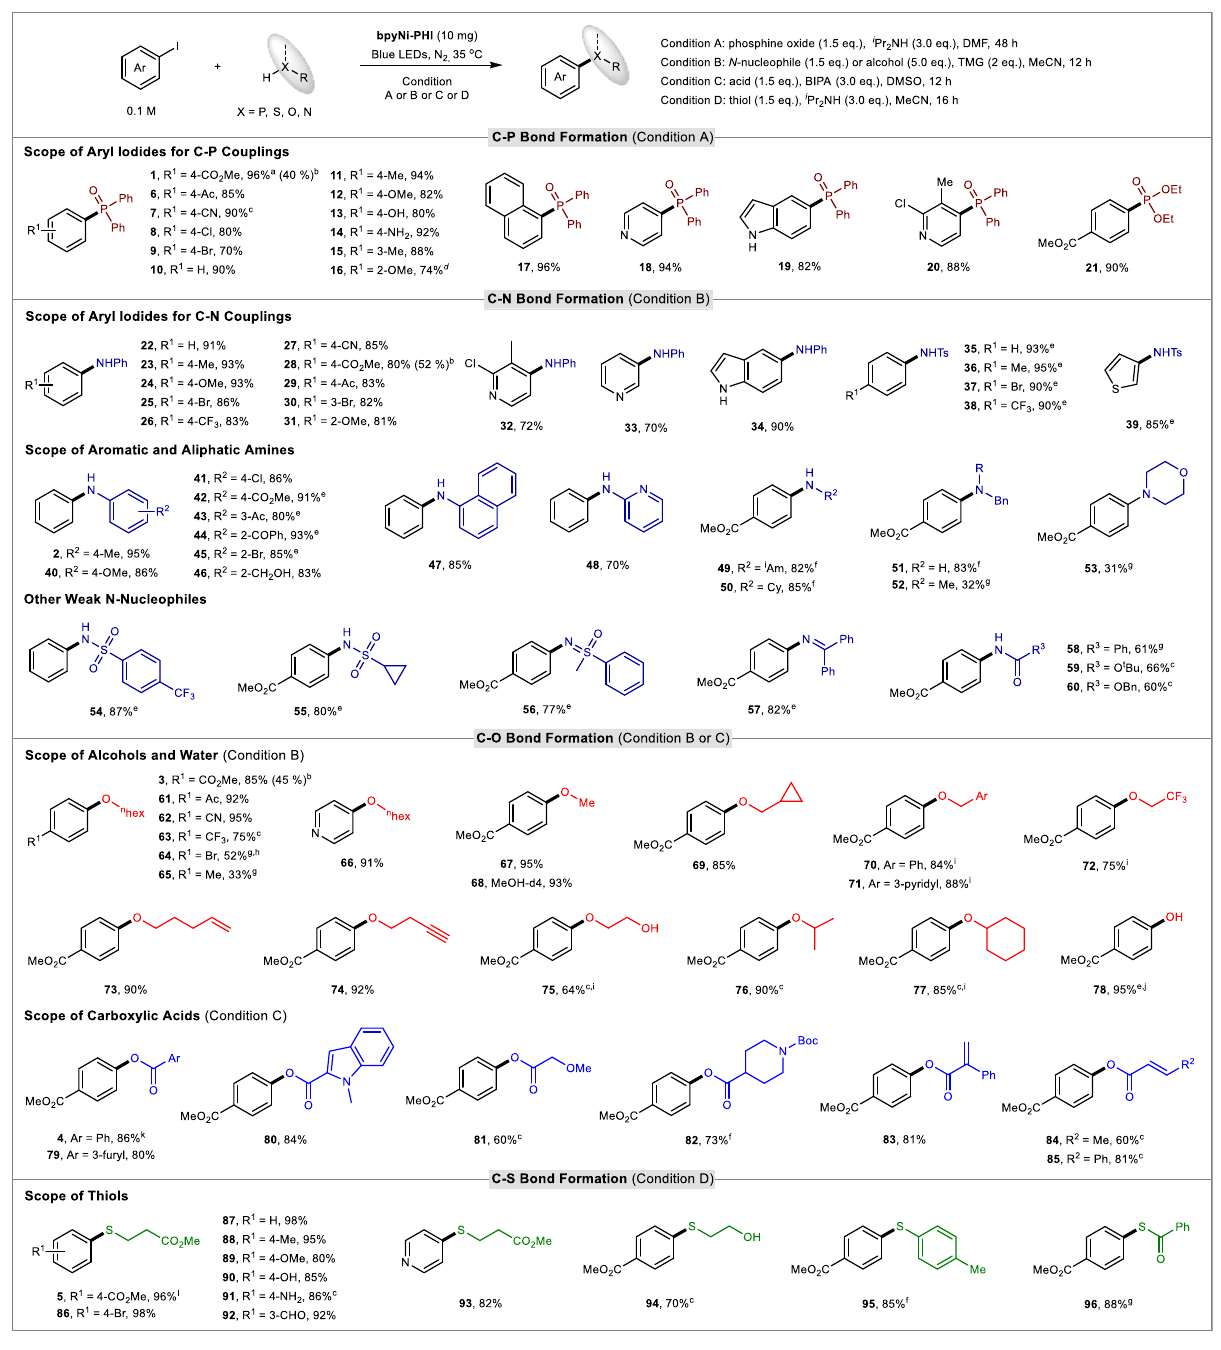
Fig. 6 | Substrate scope of bpyNi-PHI catalyzed C − P, C − N, C − O, and C − S cou- plings. Reaction conditions: aryl iodide (0.2mmol), bpyNi-PHI (10mg, 6 wt %), phosphine oxide (0.3mmol, 1.5 eq.) or alcohol (1.0mmol, 5.0 eq.) or amine (0.3mmol, 1.5 eq.) or thiol (0.3mmol, 1.5 eq). Condition A: i Pr 2 NH (0.6mmol, 3.0 eq.) in DMF (2mL). Condition B: TMG (0.4mmol, 2.0 eq.) in MeCN (2mL). Condition C: BIPA (0.6mmol, 3.0 eq.) in DMSO (2mL). Condition D: i Pr 2 NH